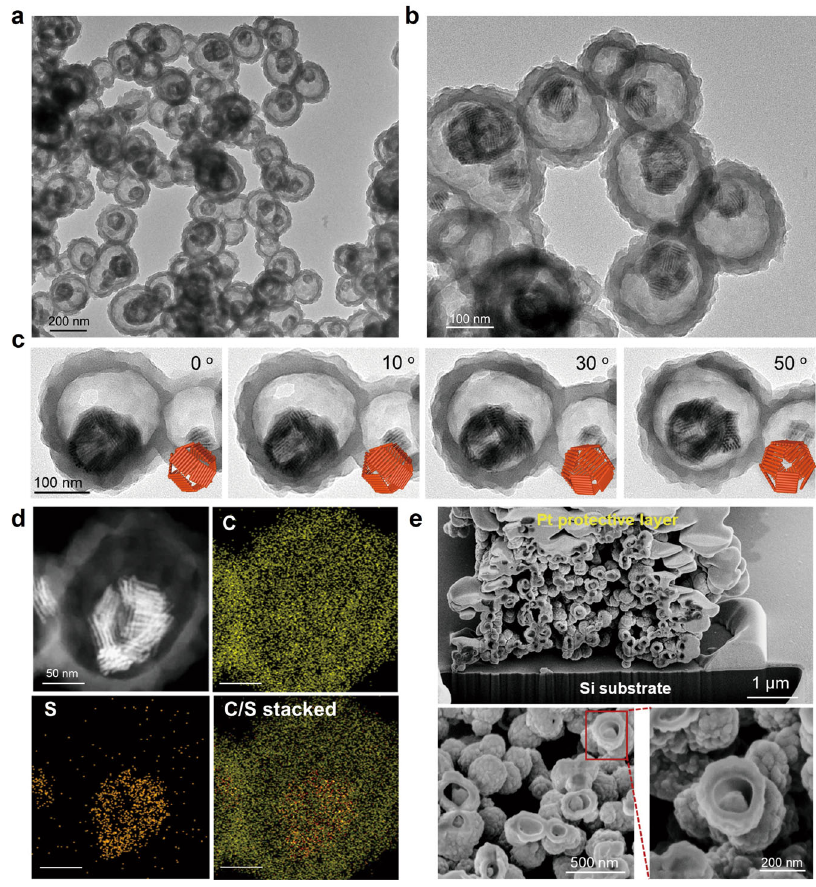
Fig.3| Morphologicalcharacterizationofthedouble-shellednanocomposites. a , b TEM images of TAPT-DMTA/NR40-H. c TEM images of TAPT-DMTA/NR40-H recorded at different tilting angles from 0 o to 50 o . d The HAADF-STEM image